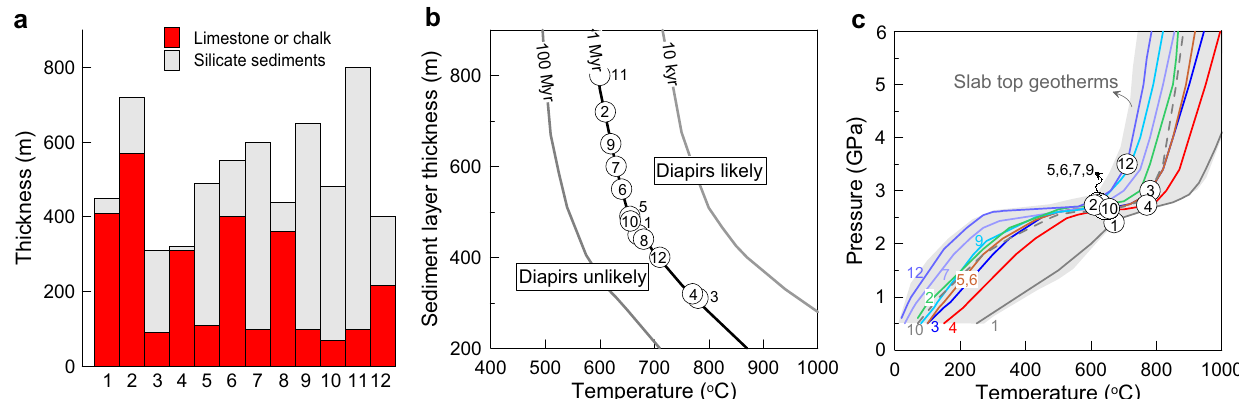
Fig. 5 Thickness of limestone-bearing sediments and buoyancy calculations. a The compiled thickness of subducted sediment columns involving limestone or chalk 3 . Numbers correspond to subduction zones: 1-Aegean, 2-Makran, 3-Peru, 4-Colombia-Ecuador, 5-Costa Rica, 6-Guatamala, 7-Mariana, 8-S.Luzon, 9-Solomons, 10-S. Sandwich, 11-Kamchatka, and 12-Kermadec. b Time needed to destabilise sediment layers expressed as temperature and sediment layer thickness for a density contrast of − 200 kgm − 3 and viscosity ratio of 1:100 between the sediment and overlying mantle from Behn, et al. 37 . The required temperatures for the initiation of diapirs from the subducted sediment columns with the limestone or chalk are obtained by projecting onto the 1 Myr line which is the time of the initiation of a sediment diapir. ( c ) Pressure – temperature paths of the slab surface for subduction scenarios with sediment columns, involving limestone or chalk 43 . We calculate the pressures for the initiation of a diapir by projecting their required temperatures onto their slab